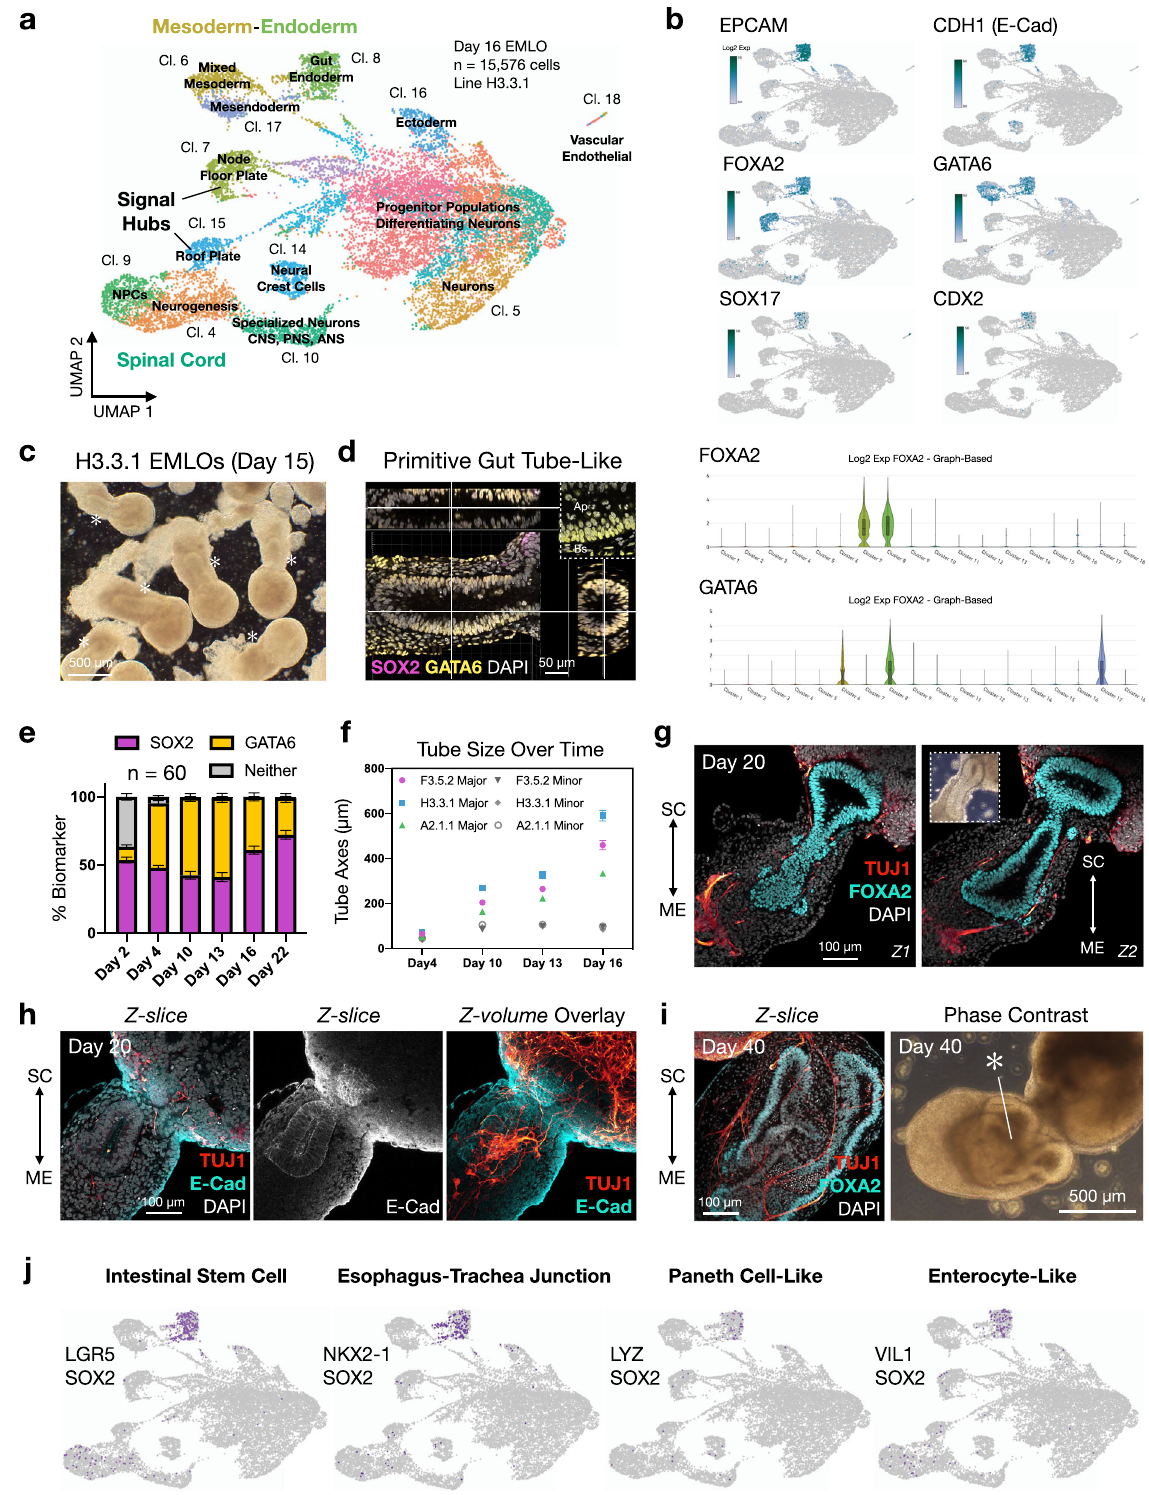
qualitative summary of EMLO biomarker distribution analyzed by IF is provided (Supplementary Table